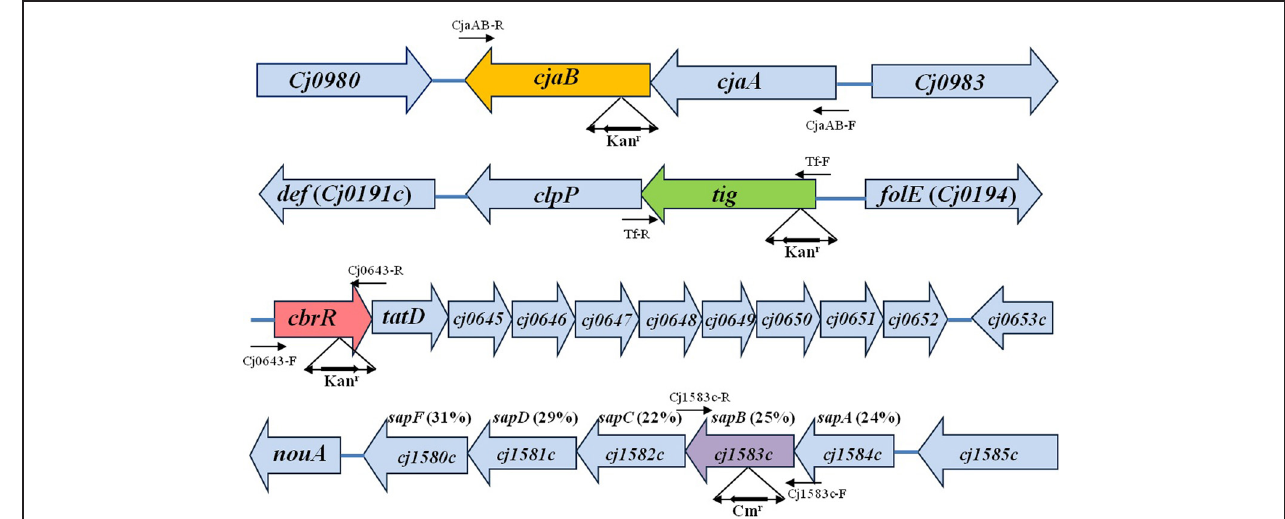
are indicated by arrows. The location and orientation of antibiotic resistance cassette are indicated below each inactivated gene. For sap operon, the aa identity of the putative sap gene to its homolog in S. enreica serovar Typhimurium LT2 is listed in parentheses.